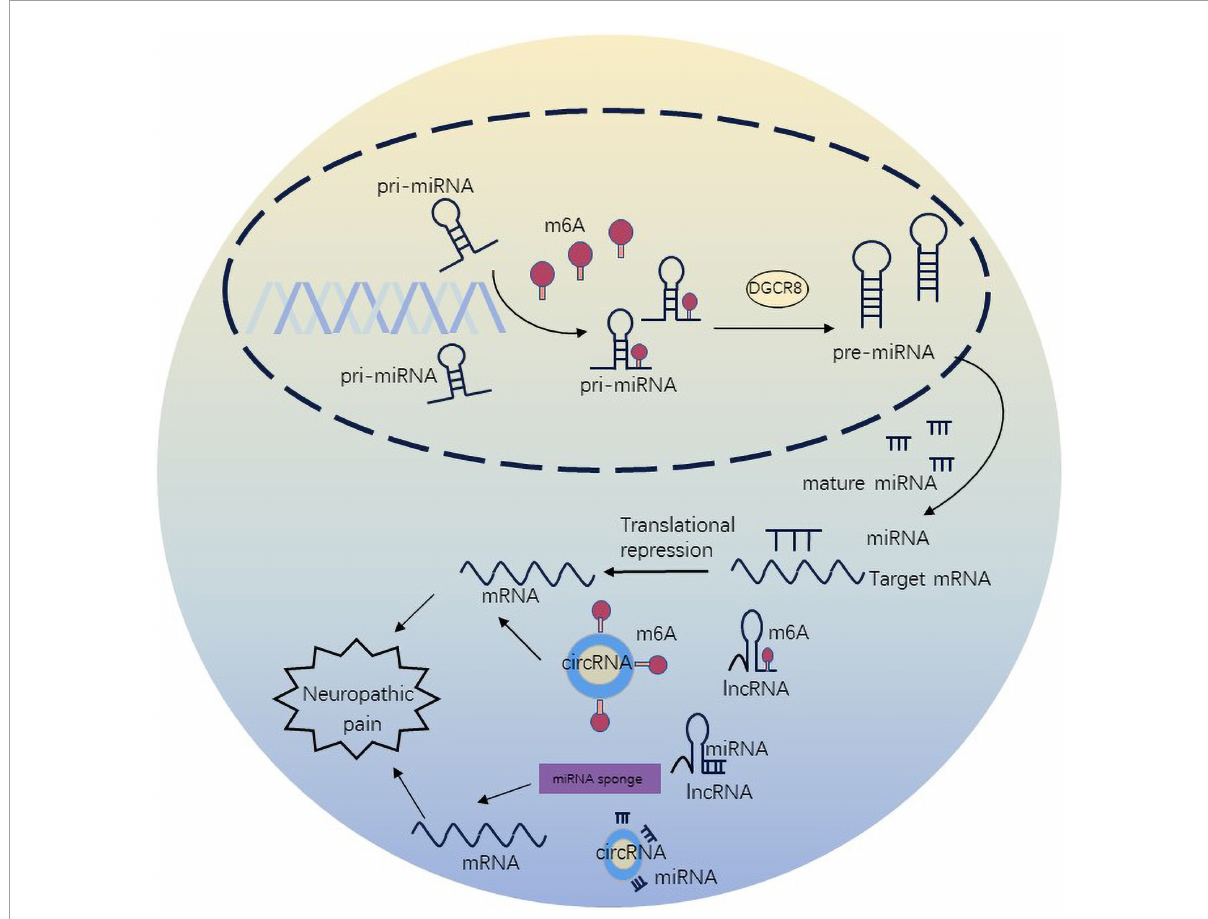
FIGURE3 n6-methyladenosine methylation regulate non-coding RNAs to affect neuropathic